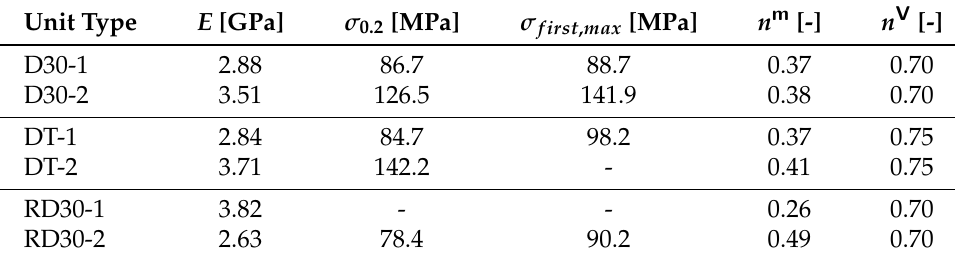
Table 4. Mechanical properties of trabecular structures from